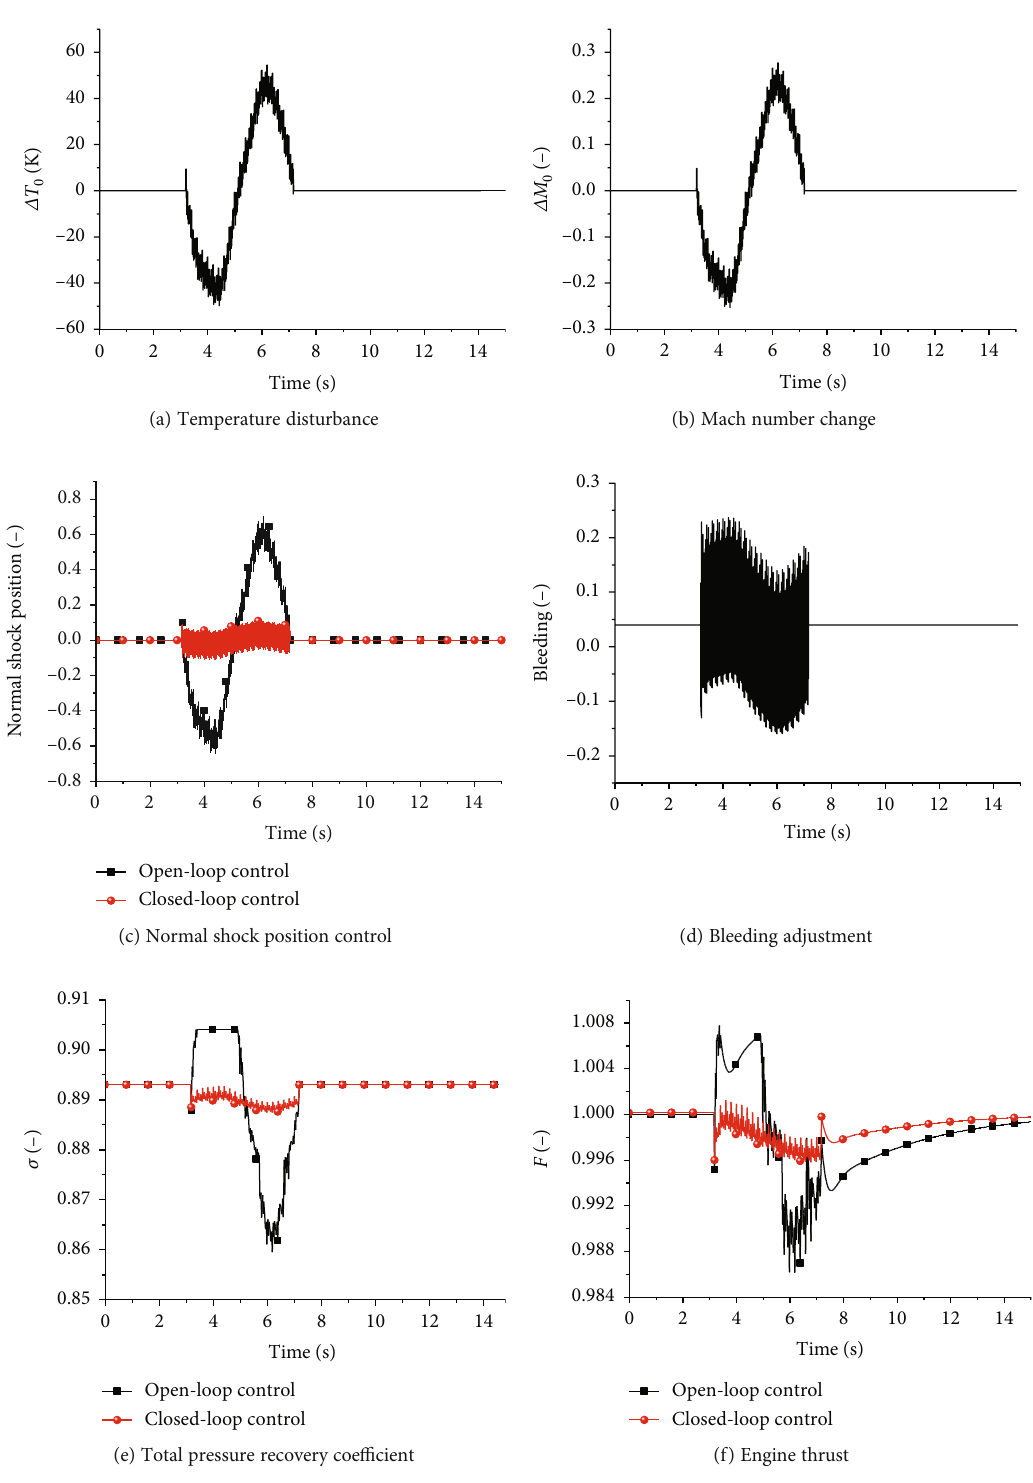
Figure 12: Simulation results of an integrated model under temperature